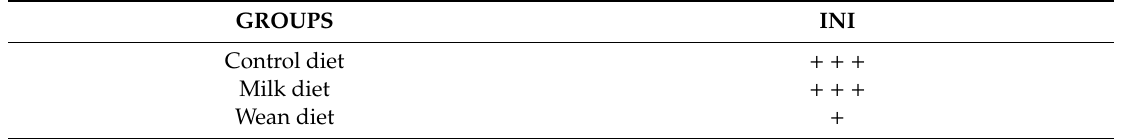
Table 1. Intensity of immunoreactivity (INI) for the oxytocin in the paraventricular